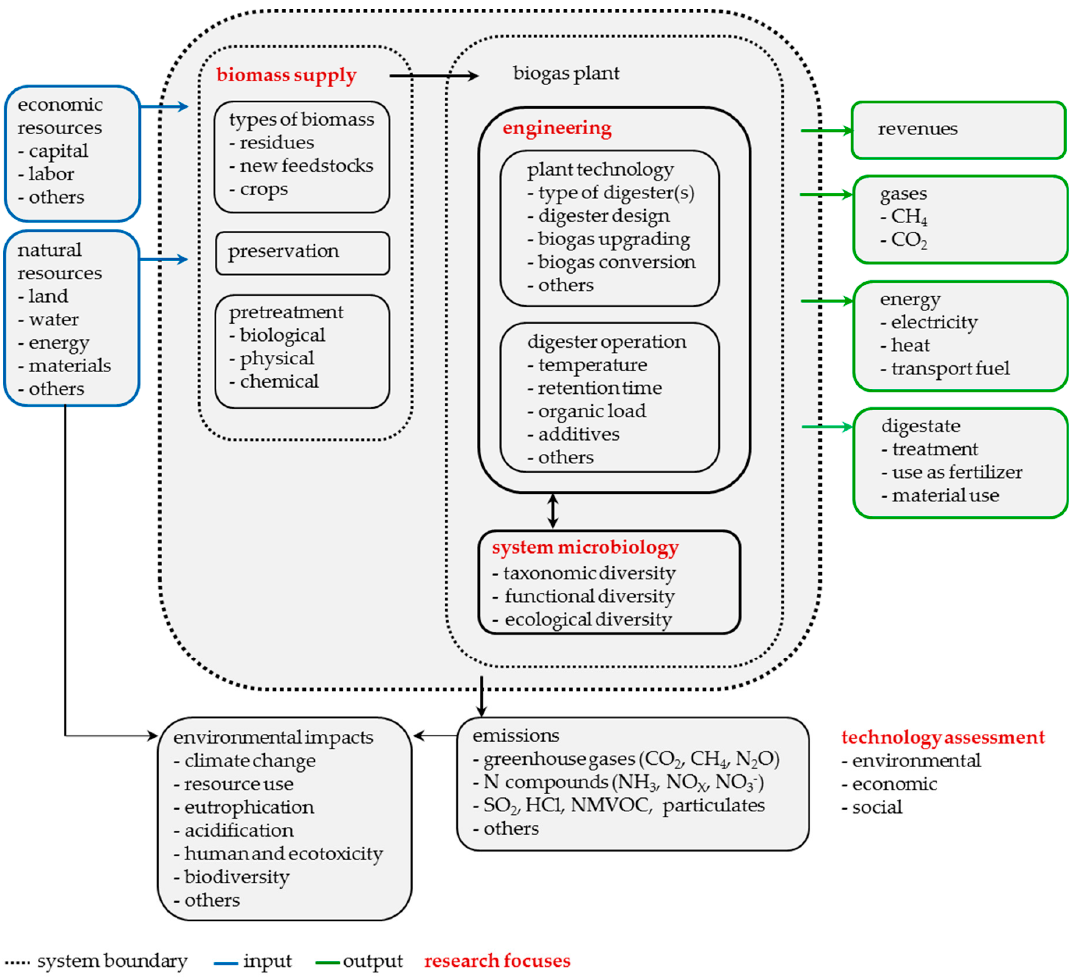
Figure 1. Systemic multidisciplinary biogas research (CO 2 —carbon dioxide, CH 4 —methane, N 2 O—nitrous oxide, NH 3 —ammonia, NO x —nitrogen oxides, NO 3- —nitrate, SO 2 —sulfur dioxide, HCl—hydrogen chloride, NMVOC—non-methane volatile organic compounds).